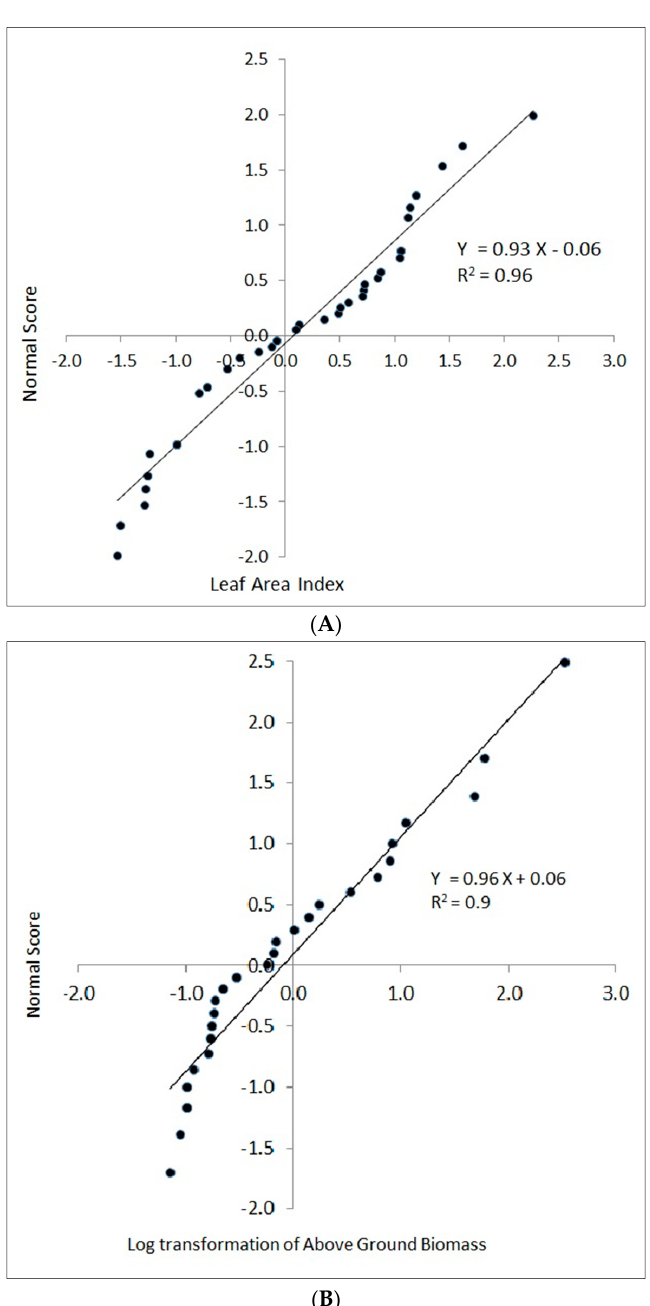
Figure 3. Normal score plots of field estimates of ( A ) leaf area index and ( B ) log-transformed above ground biomass. ground